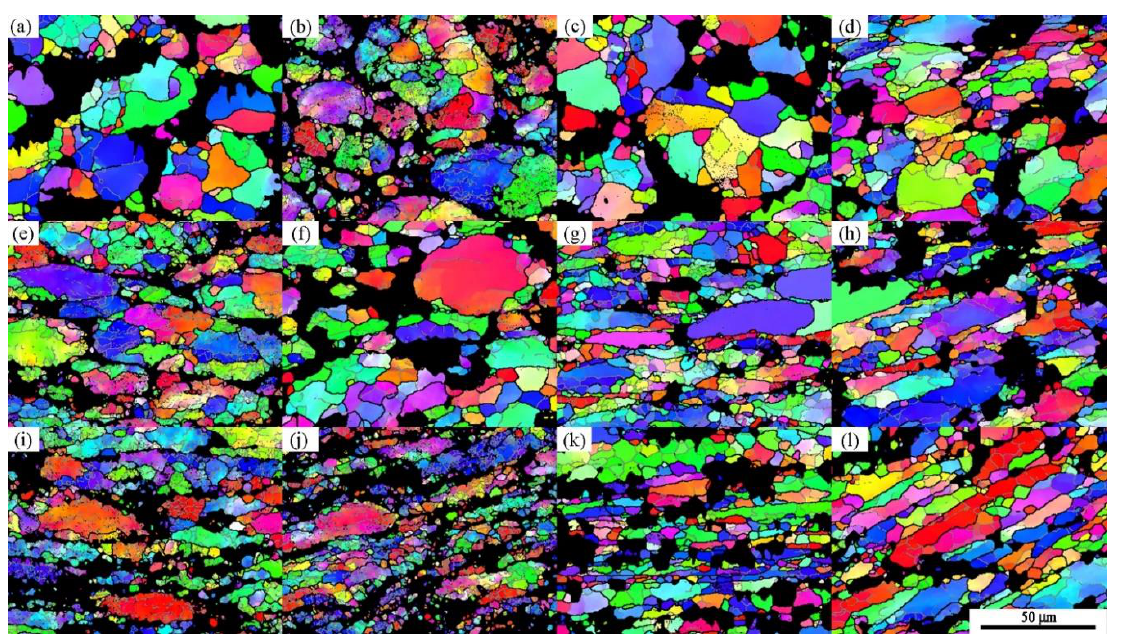
Figure 7. An EBSD image of the composite matrix microstructure at a deformation temperature of 500 ◦ C for ( a ) ε = 0.02 and 0.3 s − 1 ; ( b ) ε = 0.05 and 0.1 s − 1 ; ( c ) ε = 0.1 and 0.03 s − 1 ; ( d ) ε = 0.33 and 2.36 s − 1 ; ( e ) ε = 0.4 and 0.81 s − 1 ; ( f ) ε = 0.51 and 0.16 s − 1 ; ( g ) ε = 0.66 and 4.57 s − 1 ; ( h ) ε = 0.73 and 5.0 s − 1 ; ( i ) ε = 0.77 and 1.54 s − 1 ; ( j ) ε = 0.92 and 1.84 s − 1 ; ( k ) ε = 0.97 and 0.29 s − 1 ; ( l ) ε = 1.15 and 0.35 s − 1 .